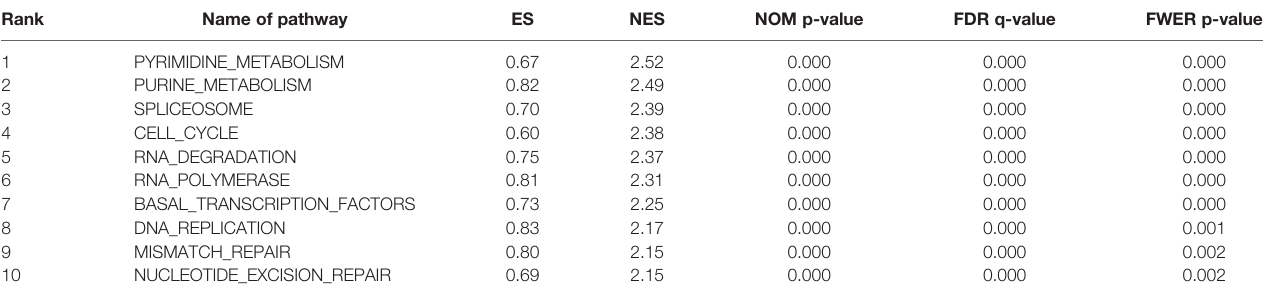
TABLE 6 | Top 10 Kyoto Encyclopedia of Genes and Genomes (KEGG) pathways enriched in 118 lung cancer cell lines from Cancer Cell Line Encyclopedia (CCLE) based on heterogeneous nuclear ribonucleoprotein C (HNRNPC). Rank Name of pathway